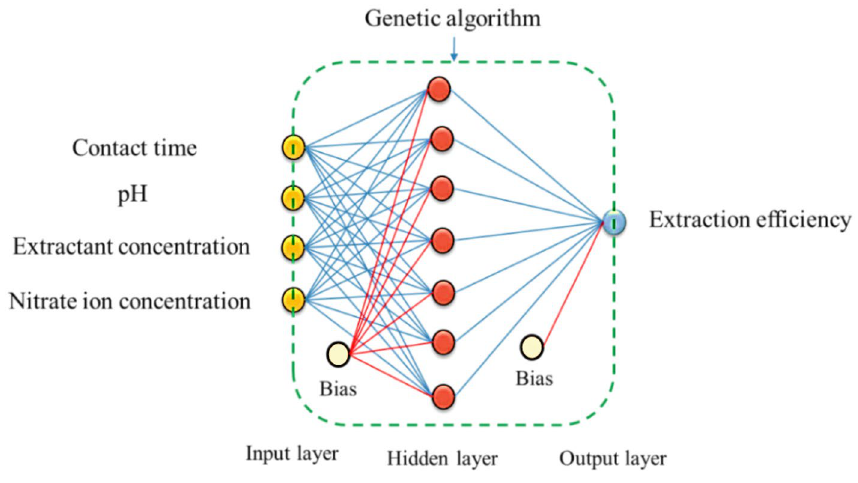
Figure 7. Architecture of GA-ANN implementation topology.